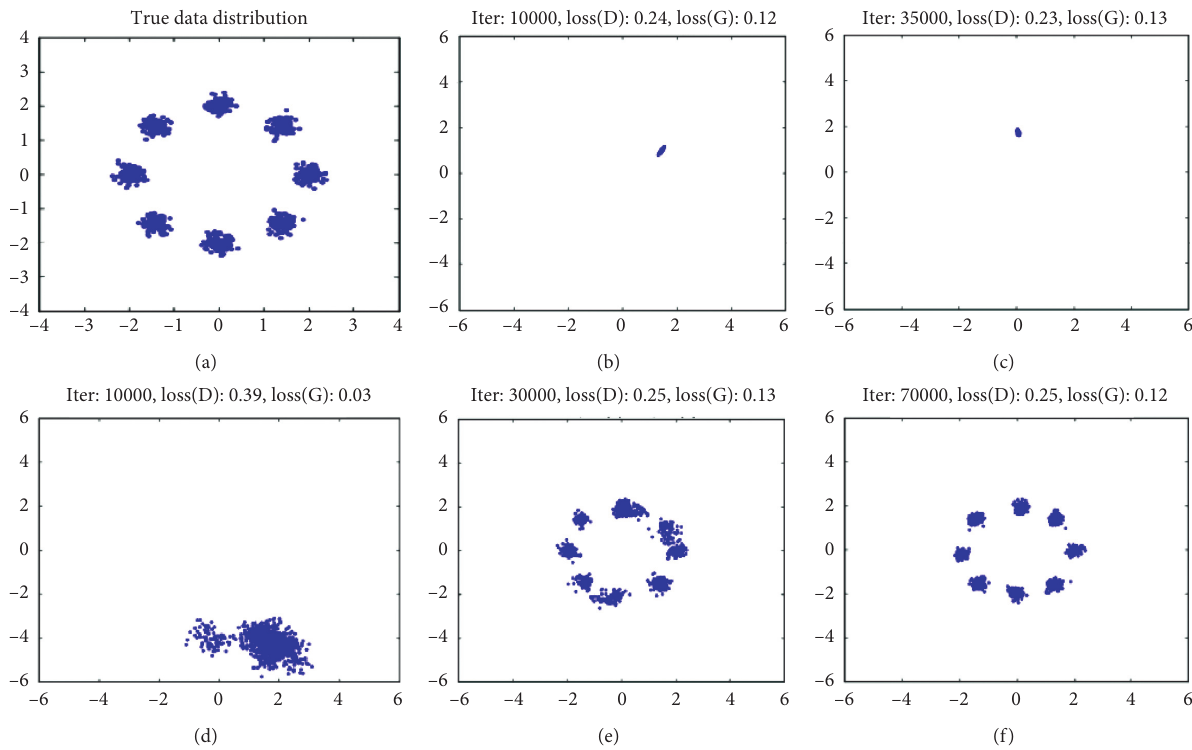
Figure 8: Comparisons of data distribution between a typical GAN and our proposed MD-GAN with different iterations: (a) the sup- position of real data distribution, (b) and (c) results generated by typical GAN after 10000 and 35000 iterations, (d), (e), and (f) represent results achieved by MD-GAN after 10000, 35000, and 70000 iterations.